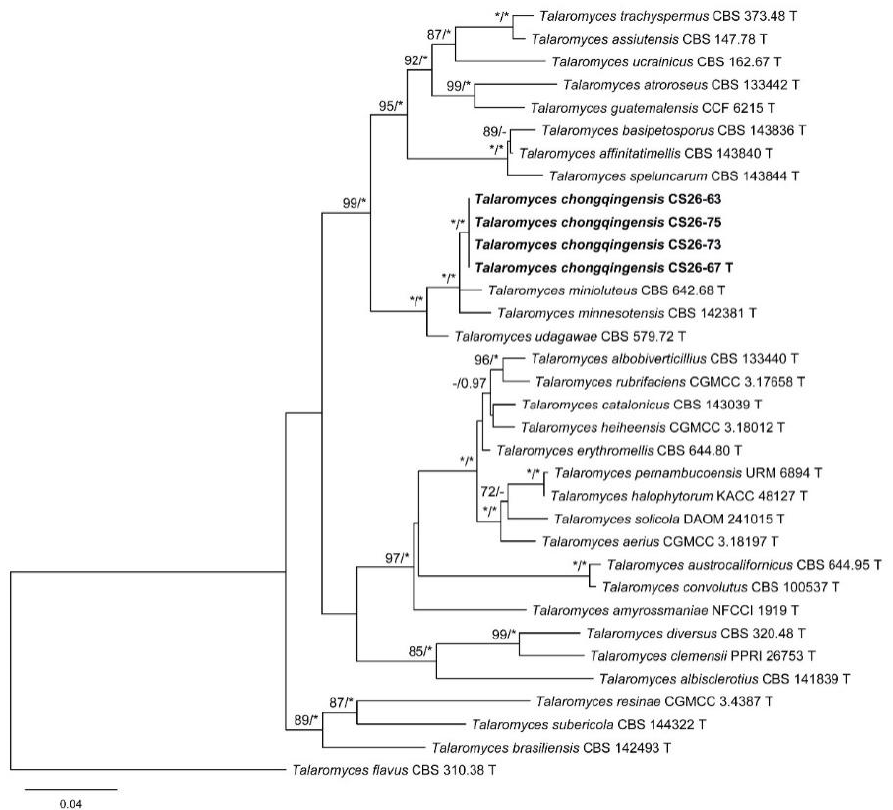
Figure 2. Maximum likelihood phylogeny of Talaromyces sect. Trachyspermi inferred from the CaM dataset. Bootstrap values ≥ 70% ( left ) or posterior probability values ≥ 0.95 ( right ) are indicated at nodes. Asterisk denotes 100% bootstrap or 1.00 posterior probability.